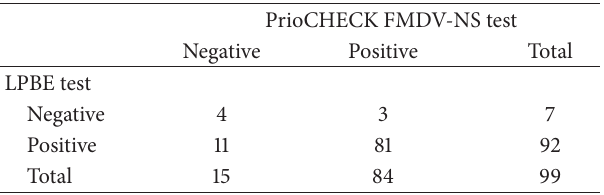
Table 4: LPBE test and PrioCHECK FMDV-NS test cross-